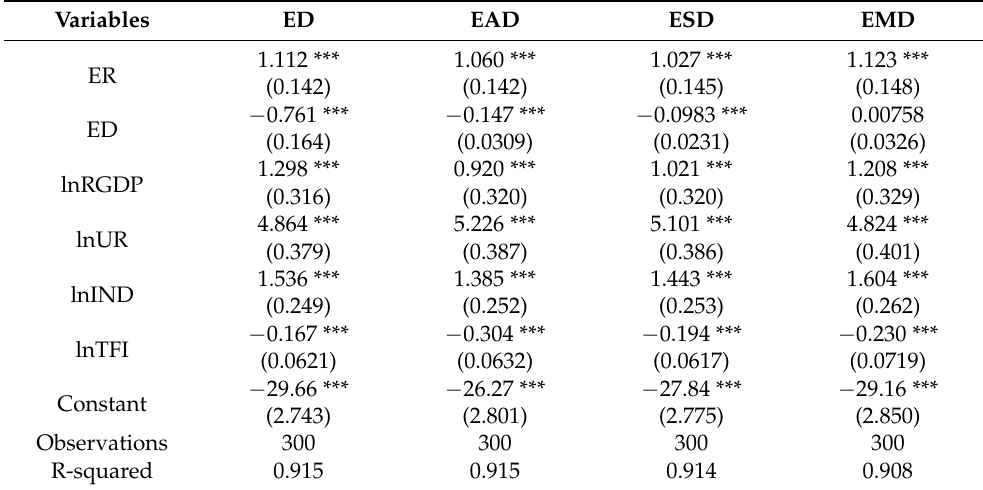
Table 2. National level regression